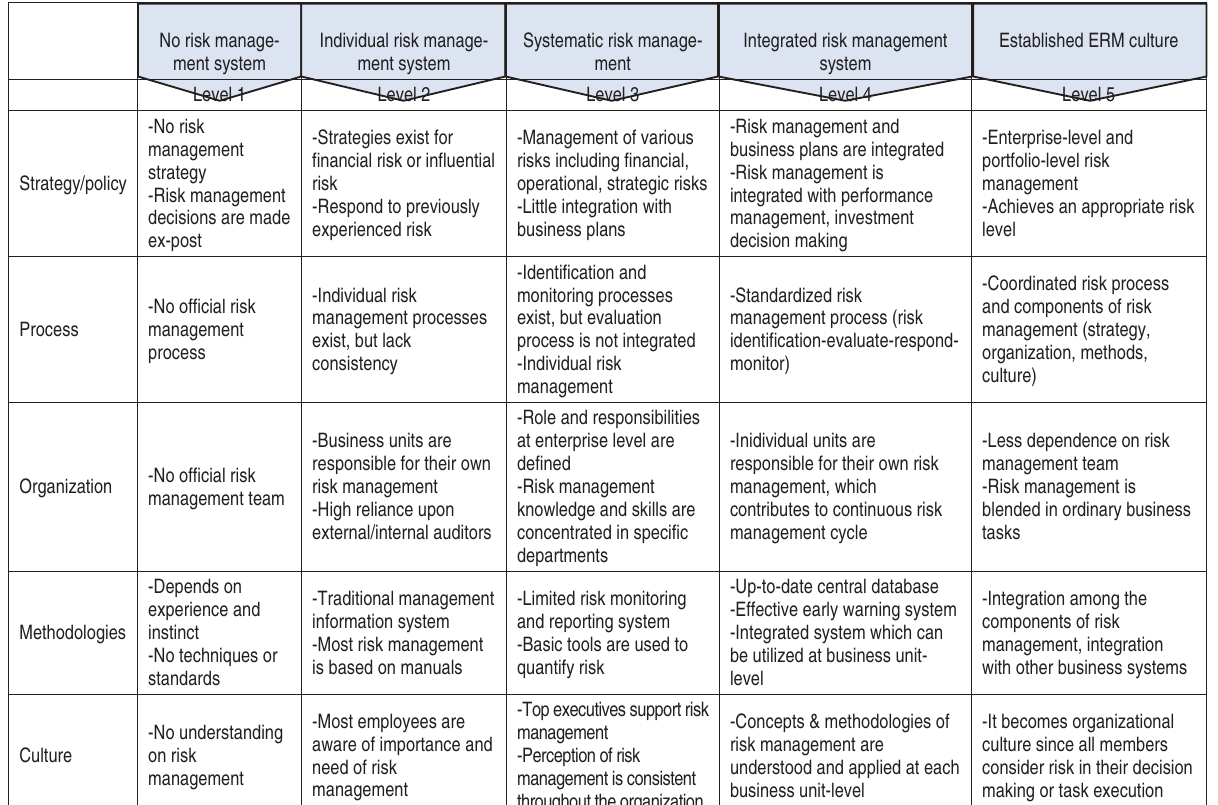
Table 3. Measurement of ERM